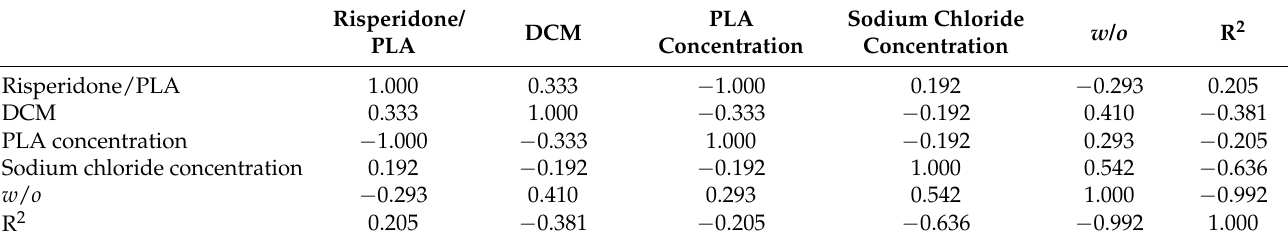
Table 2. Independent variable correlation test results.